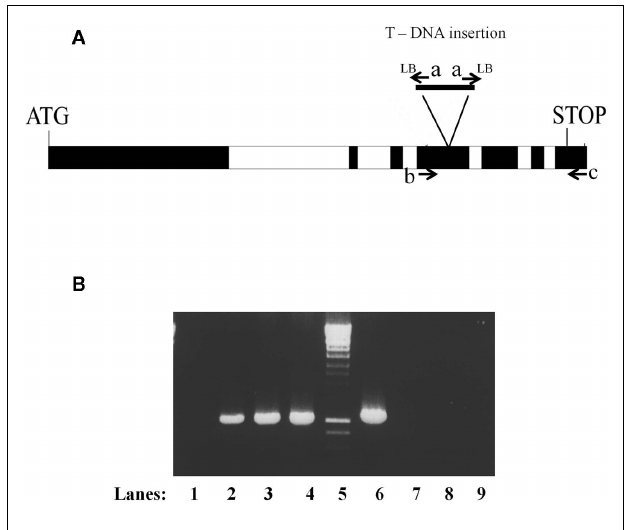
FIGURE 1 | Confirmation of the homozygous nature of the SALK_074069 insertion in plants containing theABI3MTA complementation cassette. (A) Structure of the MTA locus showing the location of the SALK_0749069 insertion (a rearrangedT-DNA insertion line with two left borders) and the oligonucleotides used in the analysis. (B) The presence of the SALK_074069 insertion was confirmed by the presence of a band of 1050bp following PCR amplification with oligonucleotides a (Lba1) and c (A63UTRR) (lanes 1–4).The homozygosity of the SALK insertion was confirmed by the lack of the 1080bp wild type band seen after amplification with oligonucleotides b (A6E4F) and c (A63UTRR) (lanes 6–9). Lanes 1 and 6 wild type, 2 and 7 Line 8, 3 and 8 Line 10, 4 and 9 Line